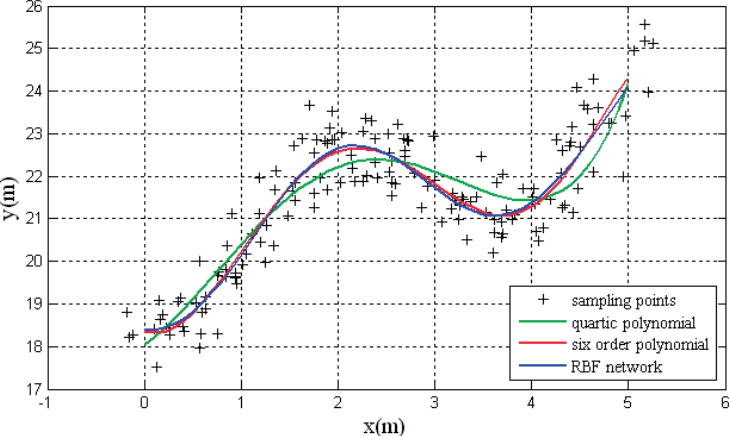
Figure 8. The fitting results of the RBF network and polynominal